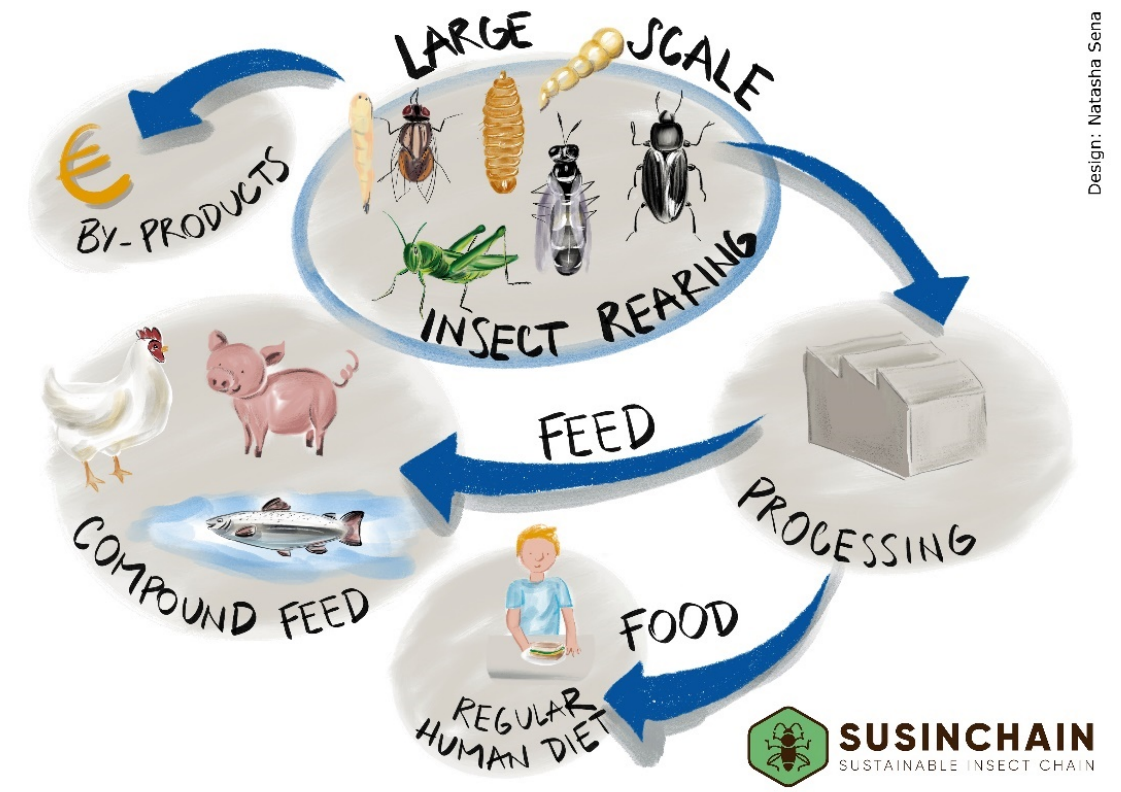
Figure 2. Insect production chain.